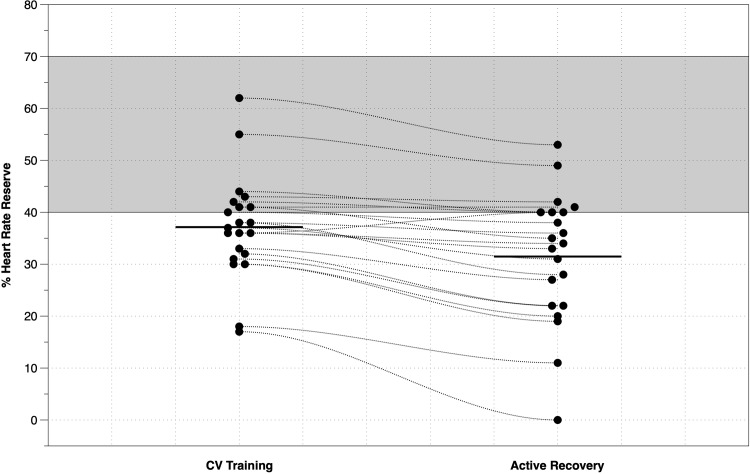
The means (horizontal bar) and individual mean distributions of CV and AR components of an 8-week Phase III CR interval training programme.The grey zone represents the recommended training intensity following national guidelines (3,12).